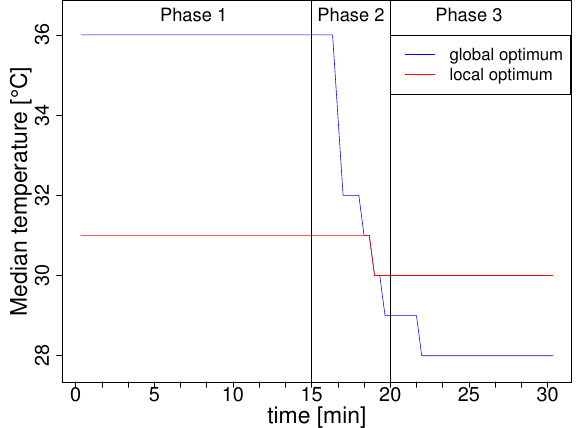
Figure 4: Course of temperature in the different phases over time in the dynamic environment ex- periment.